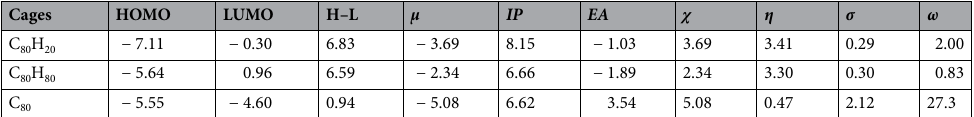
Table 3. Electronic properties of three carbon nanocages made of 80 carbons: fulleryne, C 80 H 20 , fullerane, C 80 H 80 and fullerene, C 80 (in units